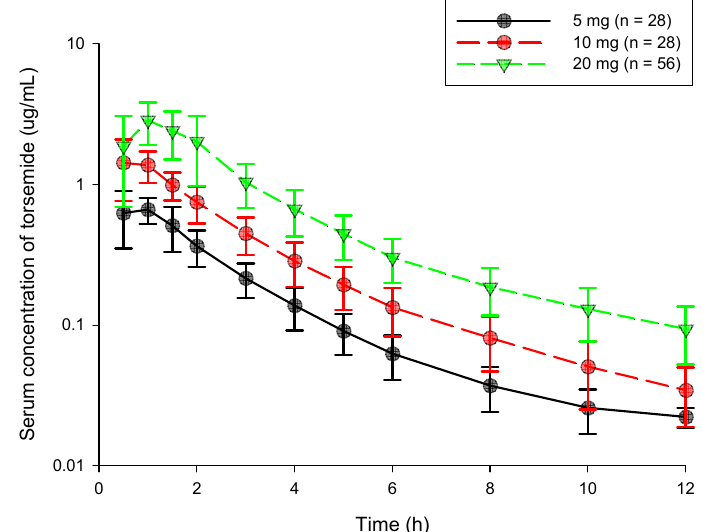
Figure 1. Serum concentration-time graph by dose according to oral torsemide administration in healthy Korean men. Black, red, and yellow-green points represent observations in 5, 10, and 20 mg torsemide administration groups, respectively. Vertical bar represents standard deviation (SD) at each point.